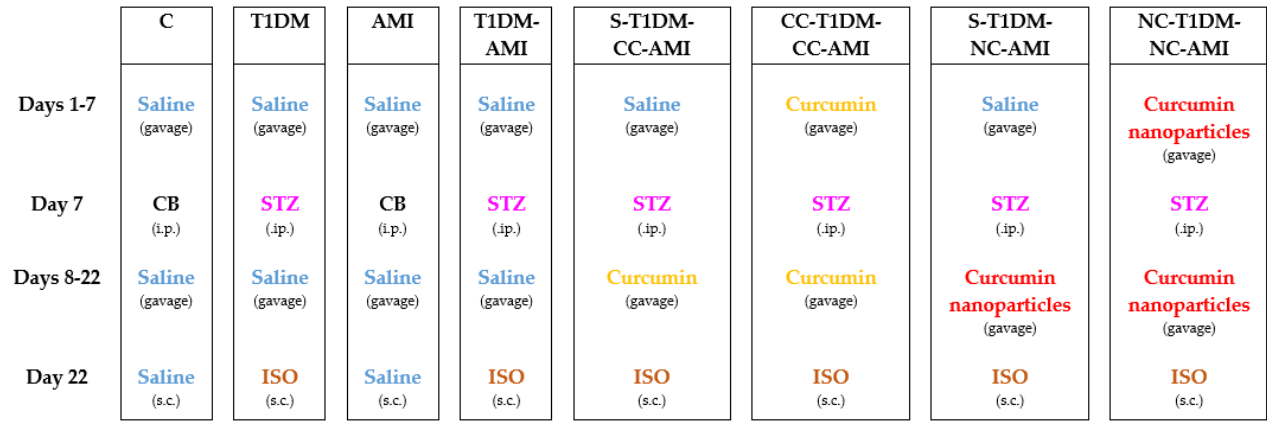
Figure 1. Flow chart demonstrating the experimental study groups. Abbreviations: C—control; AMI—acute myocardial infarction; T1DM—type 1 diabetes mellitus; S—saline (0.09%); CC—conventional curcumin; NC—solution of curcumin nanoparticles; CB—citrate buffer; i.p.—intraperitoneal; STZ—streptozotocin; s.c.—subcutaneous; ISO—isoproterenol.